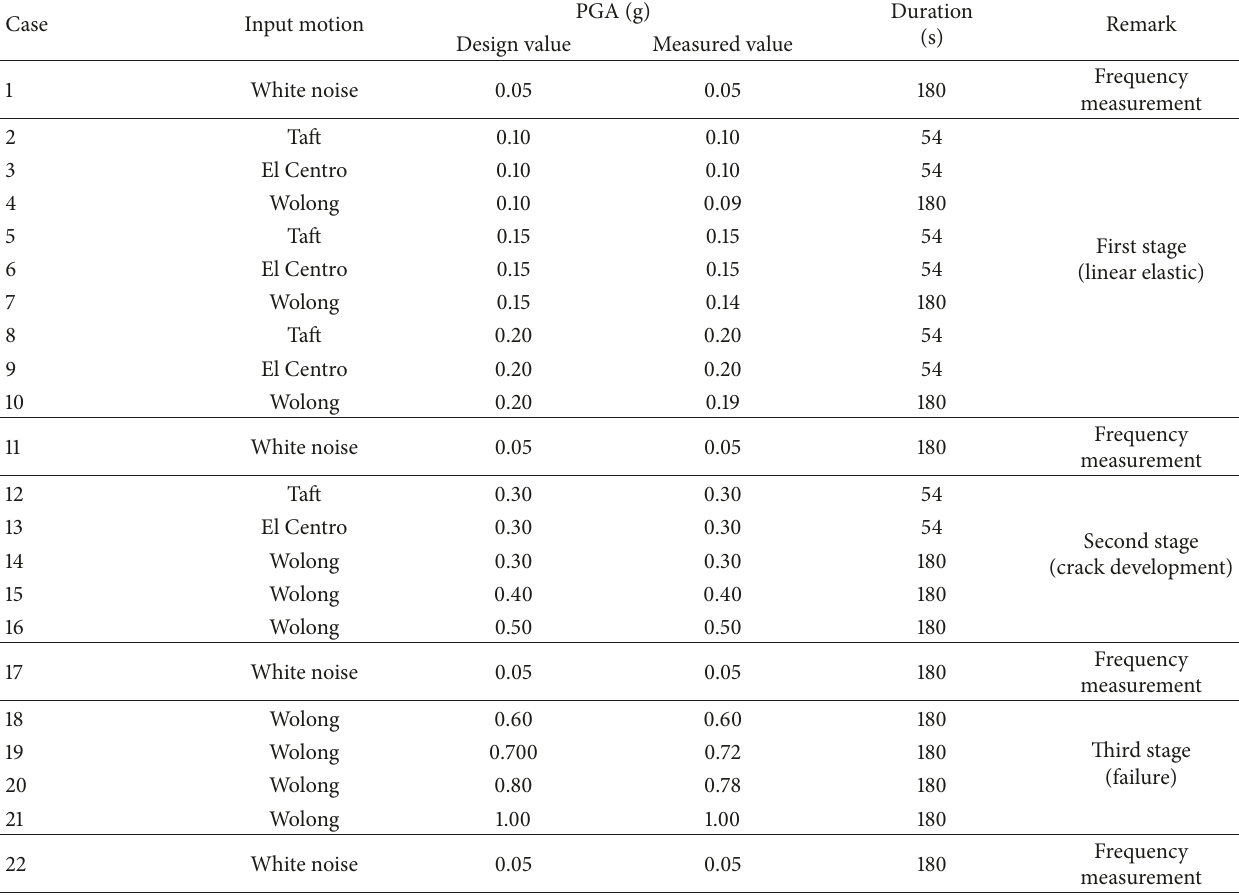
Table 3: List of testing cases.